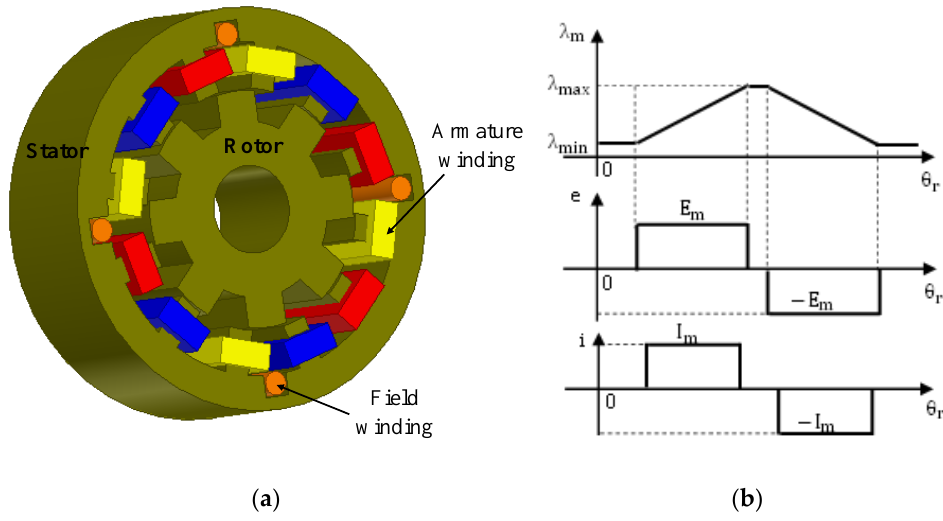
Figure 4. DSWFM with 12/8-pole: ( a ) topology; ( b ) operating principle.